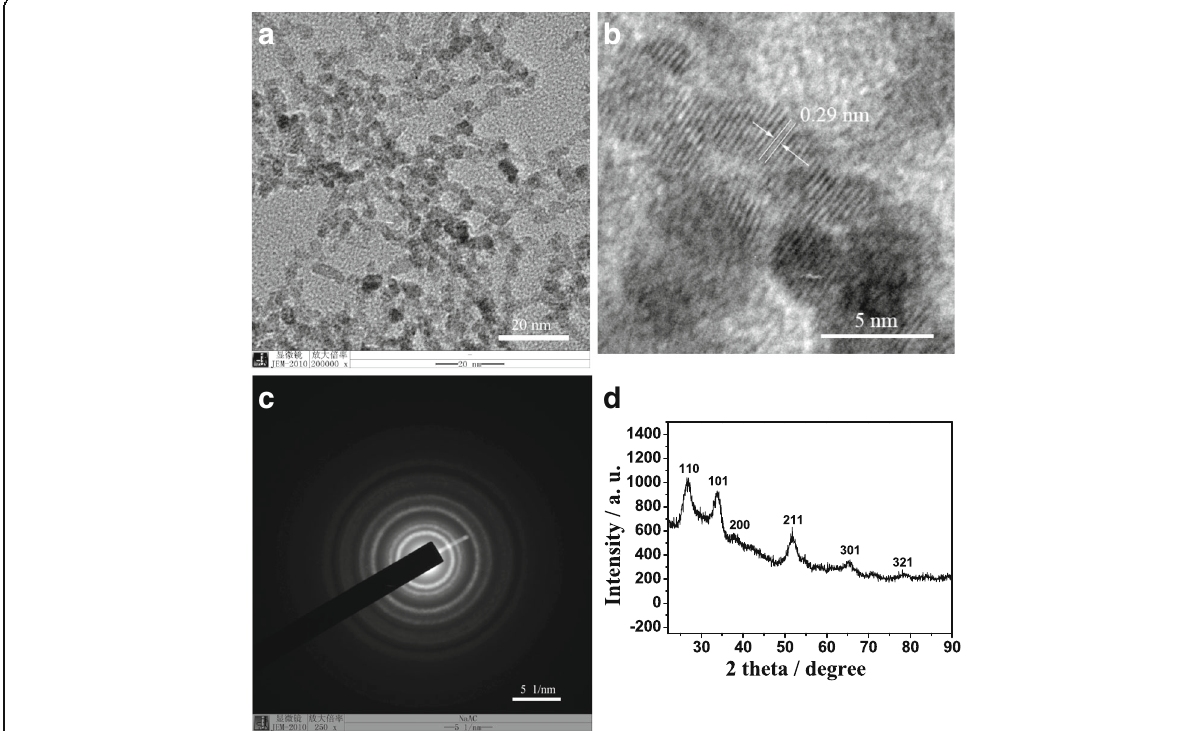
Fig. 1 TEM ( a ), HRTEM ( b ) images, selected area electron diffraction pattern ( c ) and XRD pattern ( d ) of prepared SnO 2